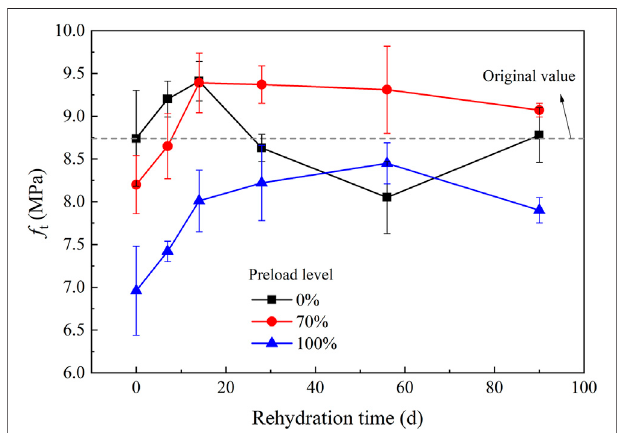
FIGURE 8 | Splitting tensile strength of UHPC-2 with increasing rehydration time.